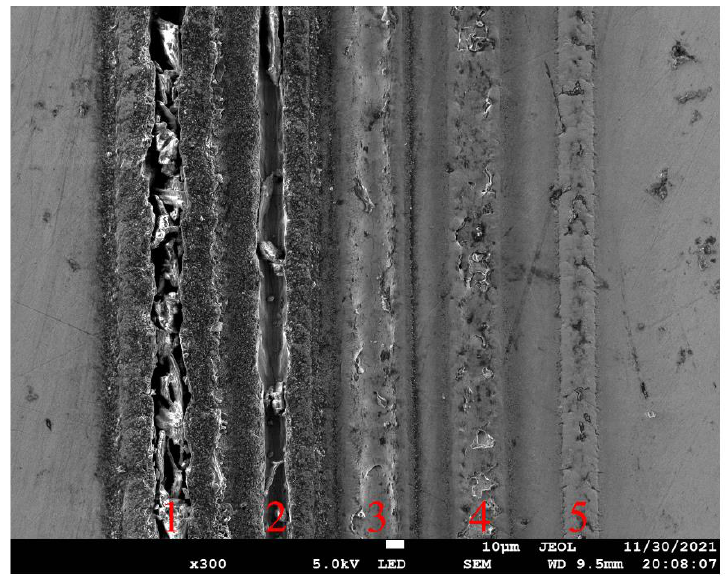
Figure 8. SEM images of ablated grooves on stainless steel sphere under different laser energy densities: 1 for 7.86 J/cm 2 , 2 for 6.55 J/cm 2 , 3 for 5.24 J/cm 2 , 4 for 3.93 J/cm 2 , and 5 for 2.62 J/cm 2 .